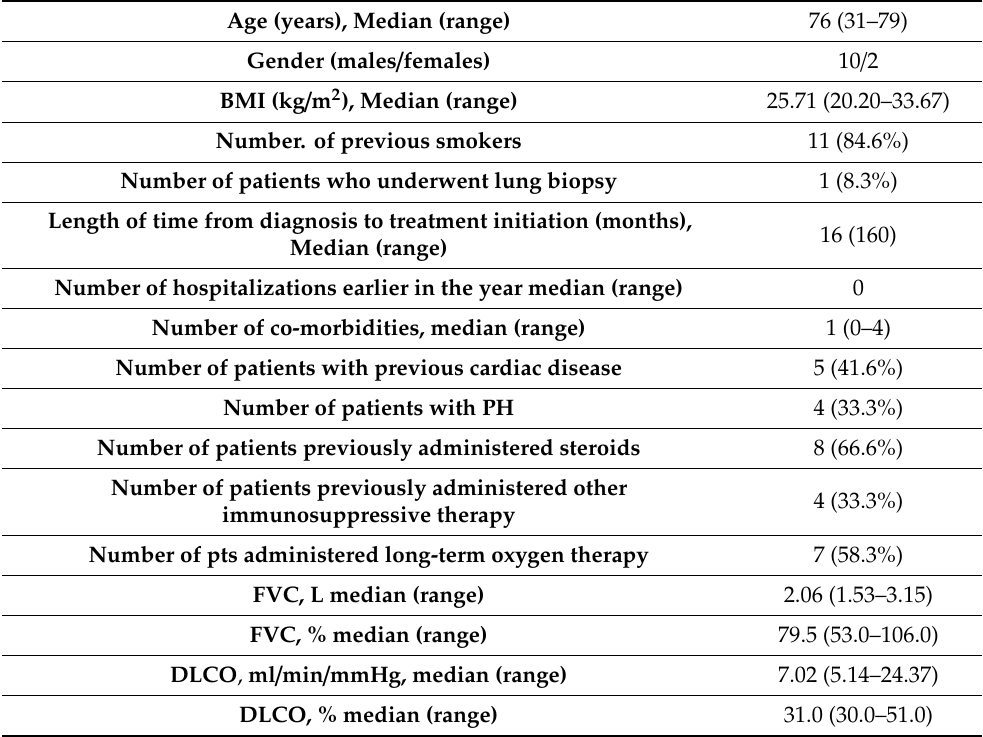
Table 1. Patients’ demographic, clinical, and pulmonary-cardiac function characteristics at the time of switching to nintedanib. (BMI = body mass index; DLCO = di ff using capacity for carbon monoxide; FVC = forced vital capacity; FEV 1 = forced expiratory volume in the 1 st second; NIV = non-invasive ventilation; PH = pulmonary